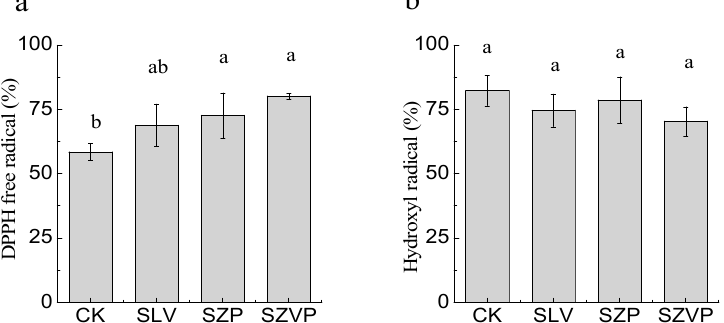
Figure 3. The DPPH free radical scavenging rate ( a ) and hydroxyl radical scavenging rate ( b ) of raw juice and fermented goji juices. Different superscript letters (a,b) in every column indicate significant difference ( p ≤ 0.05).